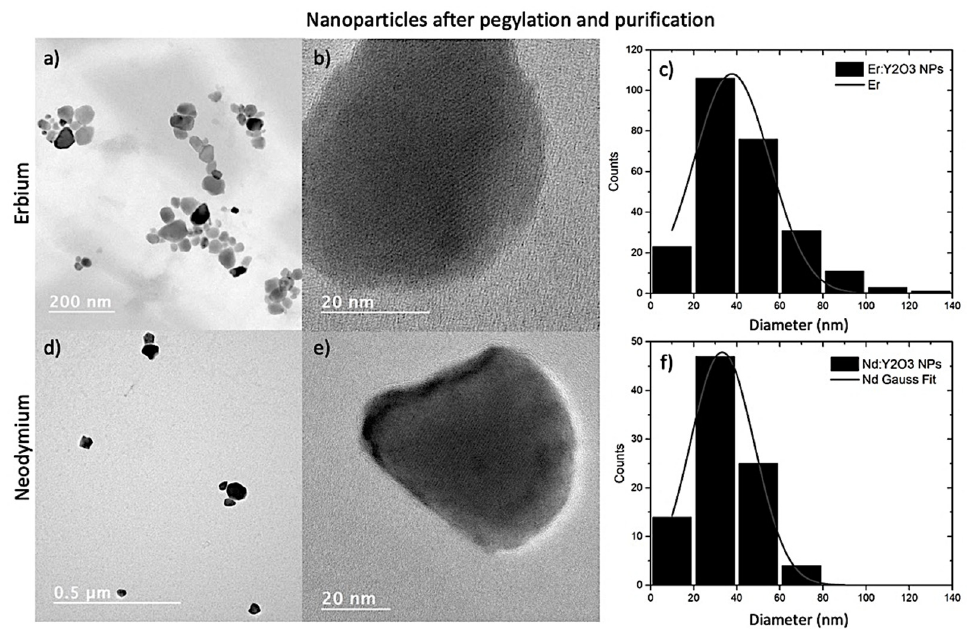
Figure 7. ( a ) TEM images, ( b ) HR ‐ TEM details and ( c ) particle diameter distribution histogram and gaussian fit obtained by TEM images of pegylated Er:Y 2 O 3 NPs sample E3; ( d ) TEM images, ( e ) HR ‐ TEM details and ( f ) particle diameter distribution histogram and gaussian fit obtained by TEM images of pegylated Nd:Y 2 O 3 NPs sample N1.